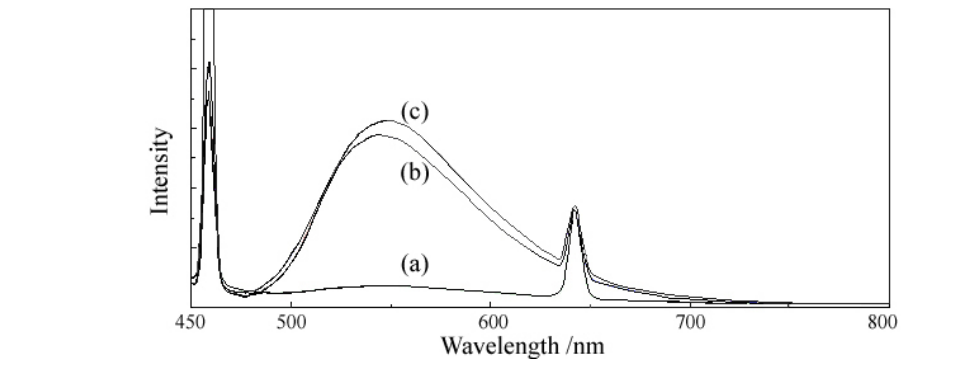
= 429 nm of ( a ) 5-hydroxyflavone (HL). exc